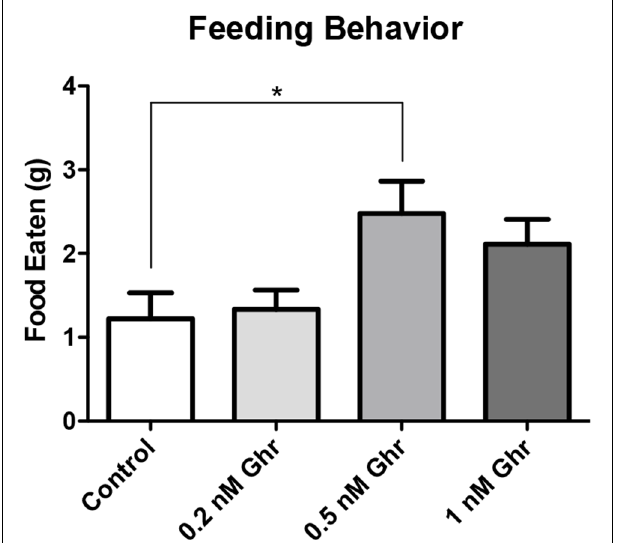
FIGURE 3 | Dose response: feeding behavior test. Weight of food consumed within 2 h following recovery from anesthetization (PND2). Values expressed as mean + SEM (one way ANOVA, p = 0.02, Tukey’s Multiple Comparison Test, ∗ p <